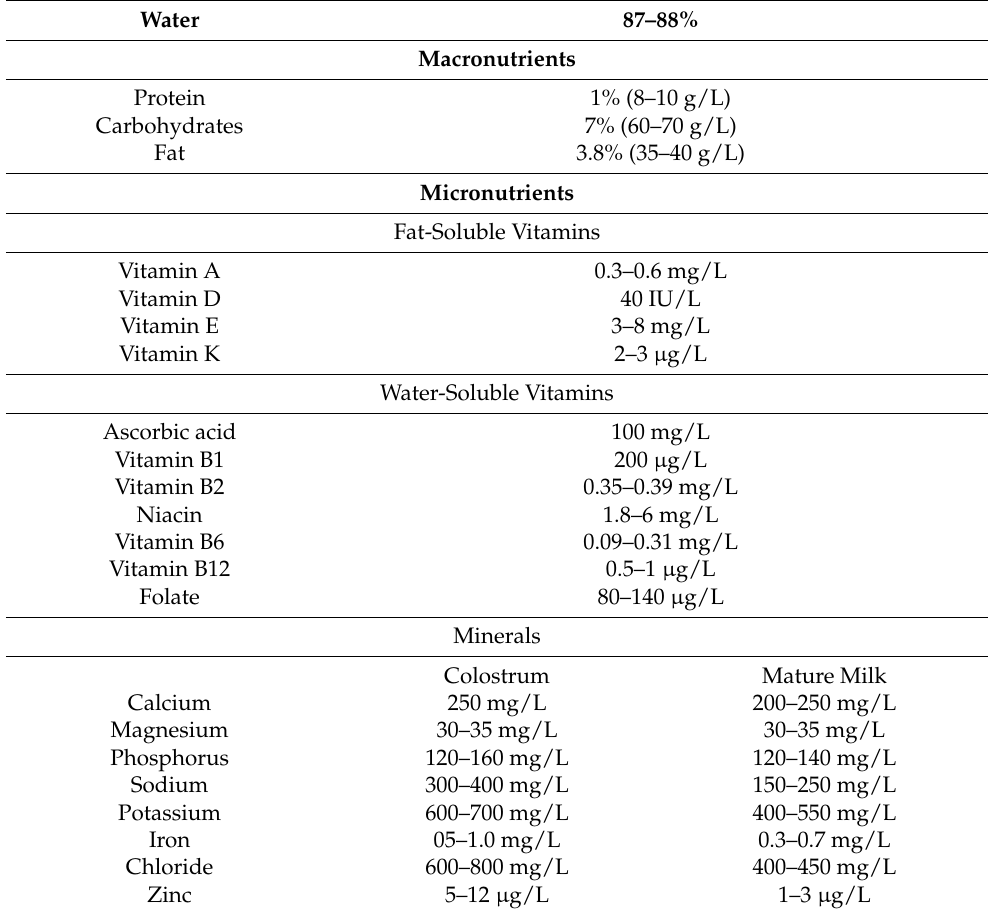
Table 1. The human milk constituents and concentrations